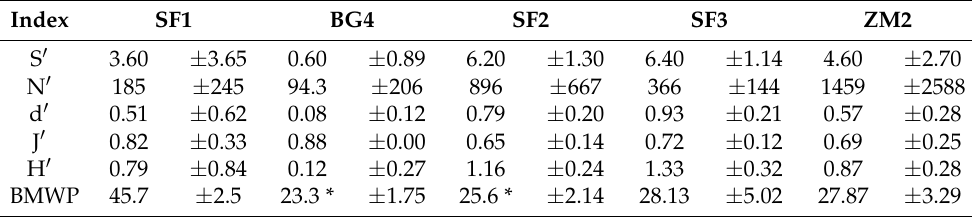
Table 2. Mean and standard deviation (mean ± SD) values of different biotic indices (abundance of taxa—S ′ ; number of individuals—N ′ ; Margalef species richness—d ′ ; Pielou evenness—J ′ ; Shannon– Wiener diversity—H ′ ; and BMWP score) per square meter at each sampling station.